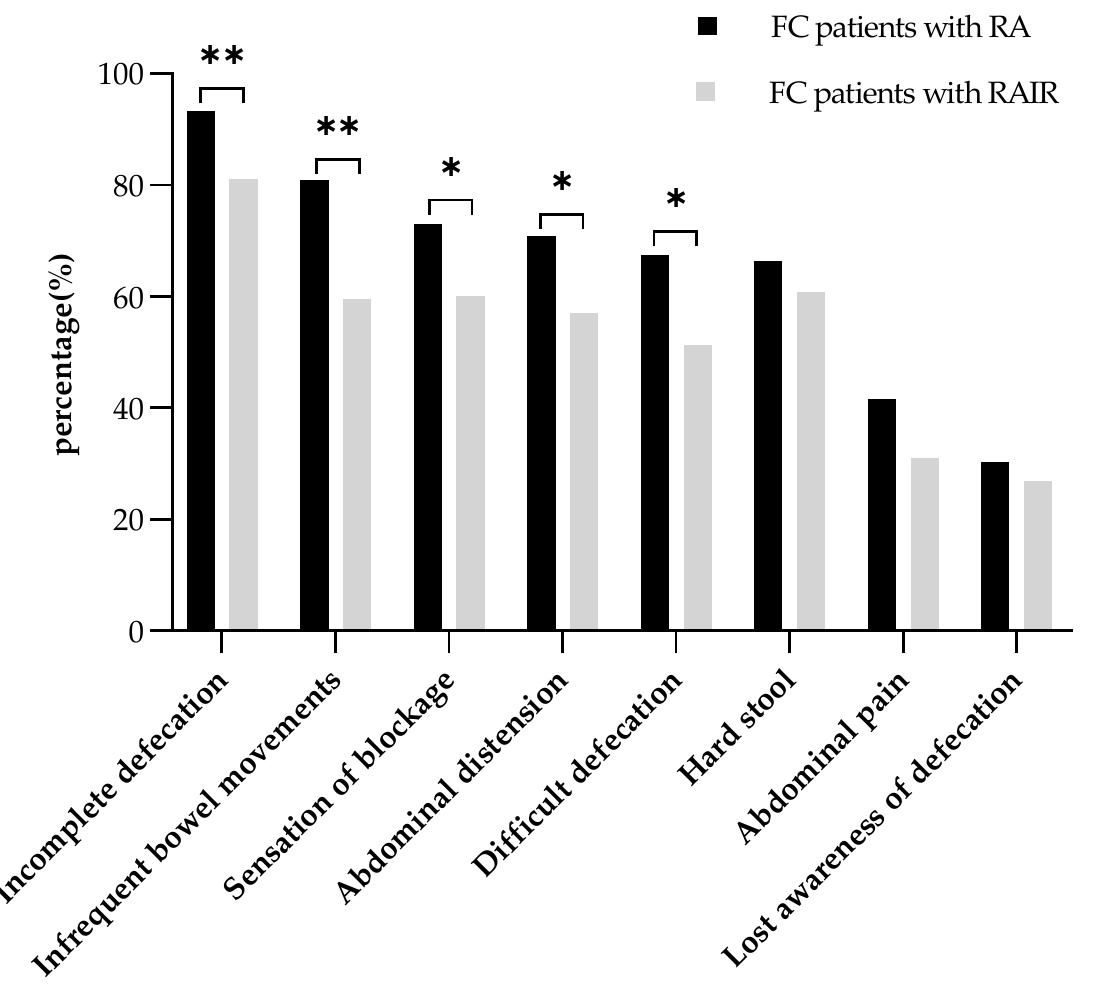
Figure 3. Frequency of common constipation symptoms in FC patients with RA and those with RAIR using the chi-squared test. * p < 0.05; ** p < 0.01. Abbreviations: FC, functional constipation; RA, rectoanal areflexia; RAIR, rectoanal inhibitory reflex. Table 2. The scores of different scales.